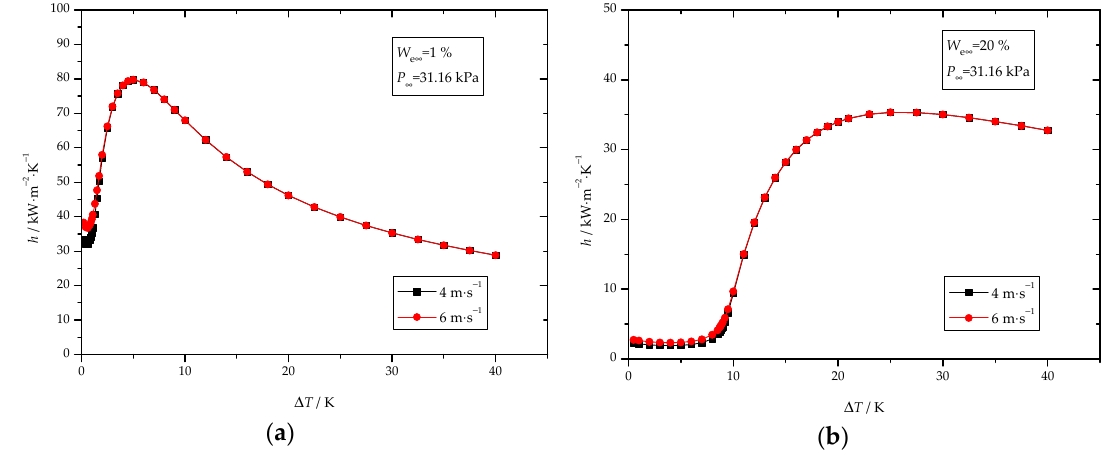
Figure 8. Calculated condensation heat transfer coefficients on different velocities at ( a ) W e ∞ = 1 % P ∞ = 31.16 kPa; ( b ) W e ∞ = 20% P ∞ = 31.16 kPa.